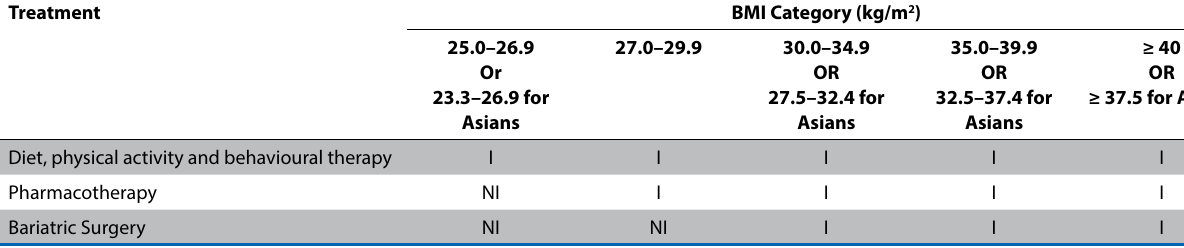
Key: NI – Not Indicated; I – Indicated for selected for motivated patients